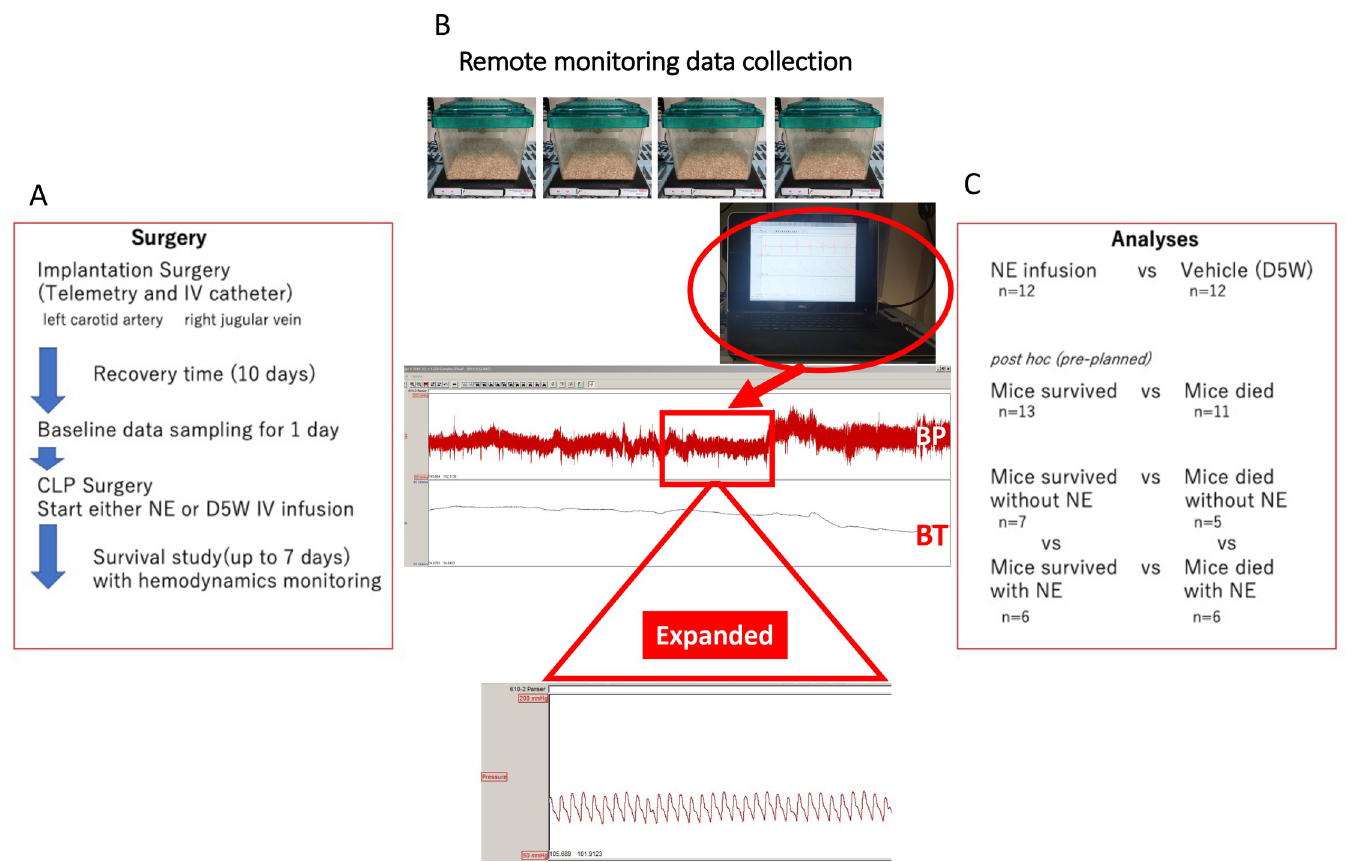
Fig 1. Flow chart and analyses design. IV: intravenous, CLP: cecal ligation puncture, NE: norepinephrine, D5W: 5% dextrose in water, BP: blood pressure, BT: body temperature.